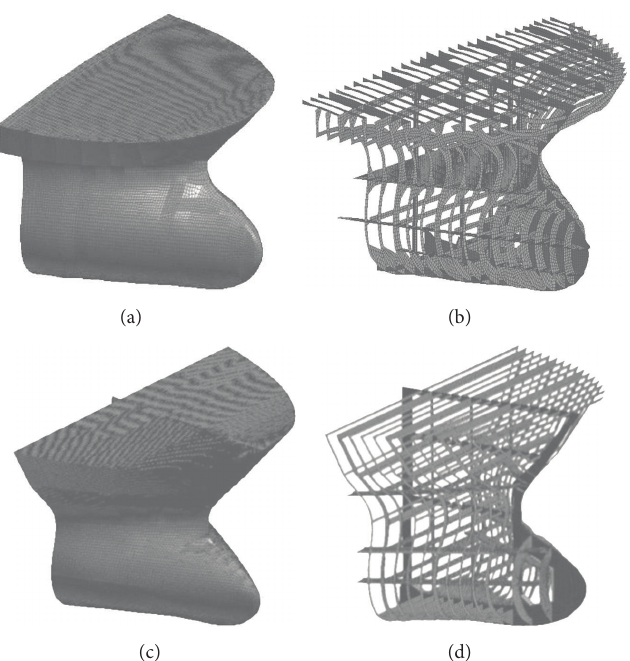
Figure 2: Finite element model of ship bows: (a) 5,000 DWT with outplate; (b) 5,000 DWT without outplate; (c) 10,000DWT with outplate; (d) 10,000DWT without outplate.